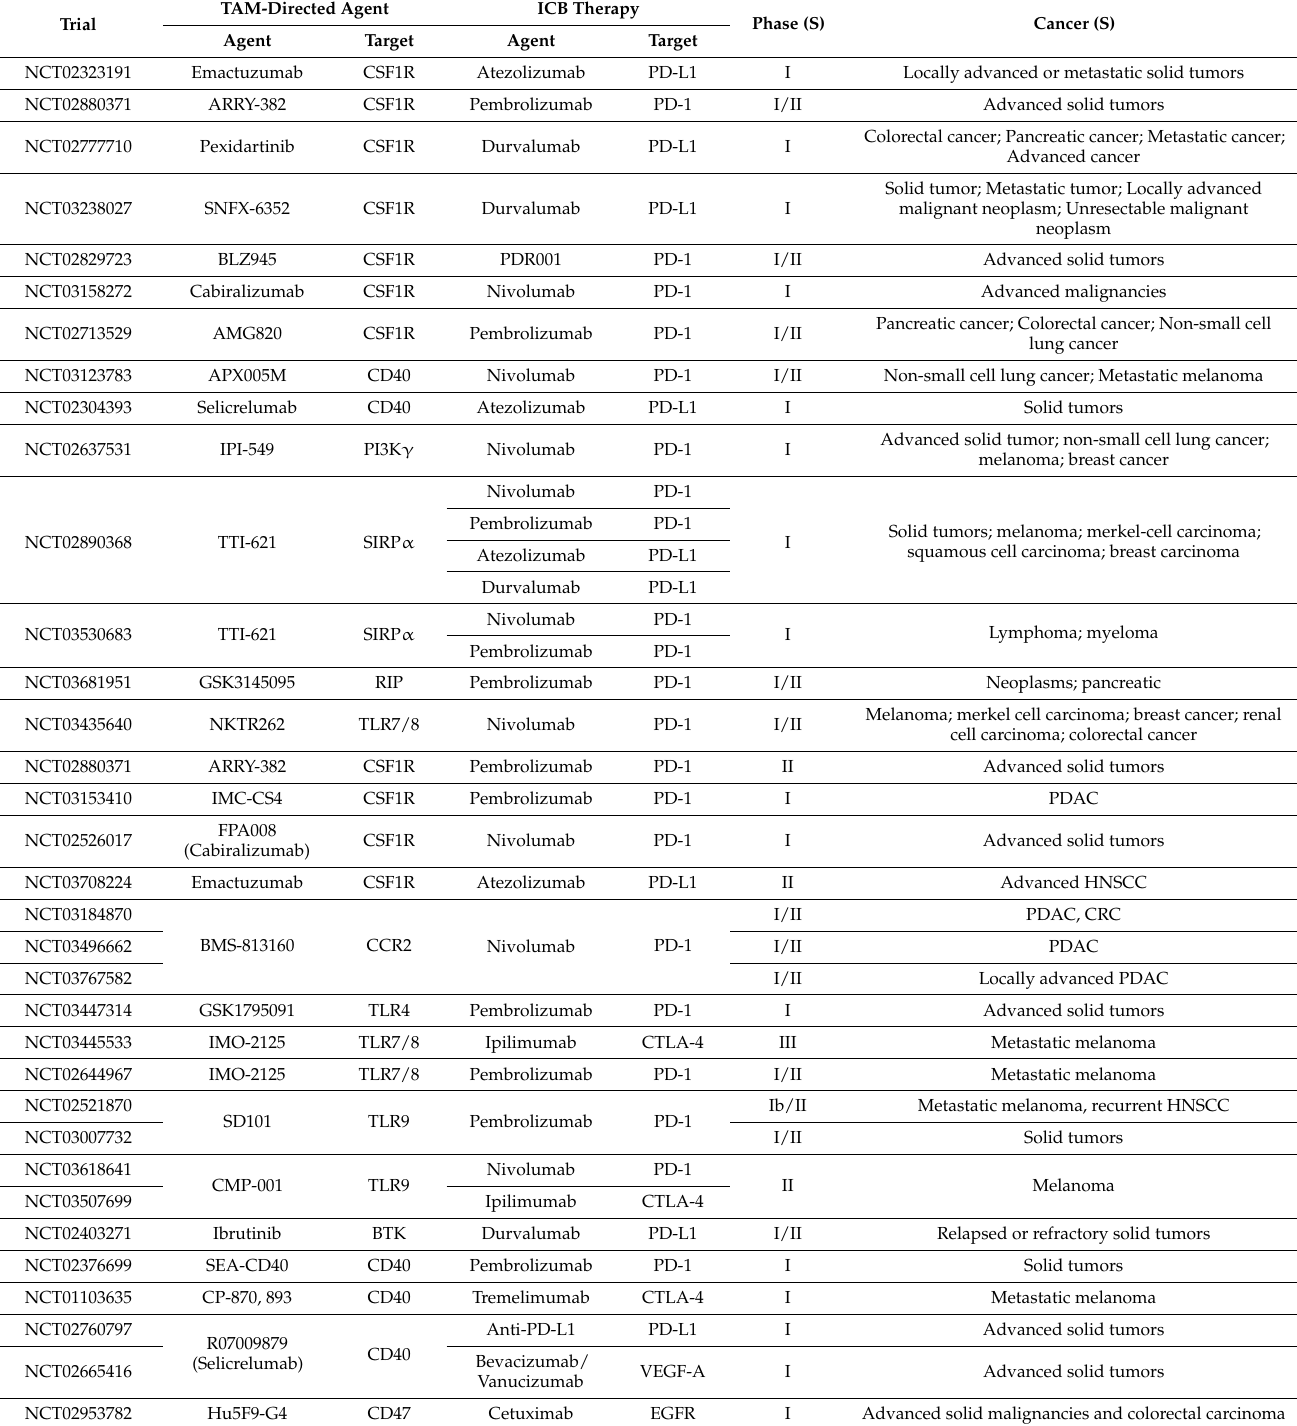
Table 4. List of clinical trials targeting TAMs in combination with immune checkpoint blockade therapies for various cancers.